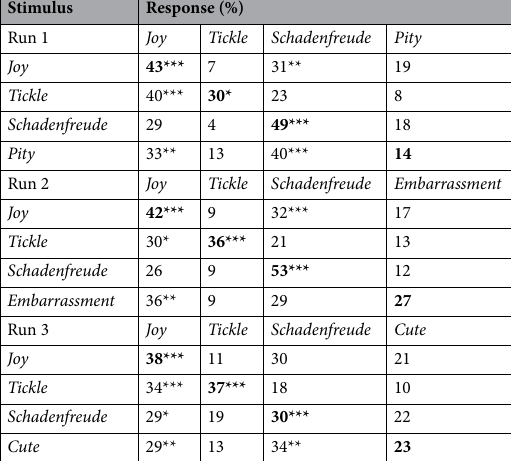
Table 3. Confusion matrices for the three runs in Experiment 1. Data in bold represent correct classification. Asterisks denote significant recognition above 25% guessing probability (* p < .05; ** p < .01; *** p < .001; one- sample t-tests vs